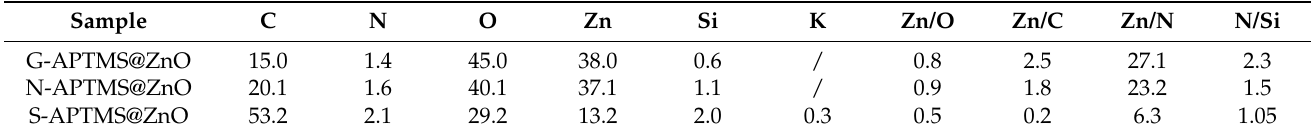
Table 3. EDX analyses of the coated ZnO samples. Atomic percentages of C, N, O, Zn, and Si averaged over three different areas for each sample. In addition, the atomic ratios between the various elements are